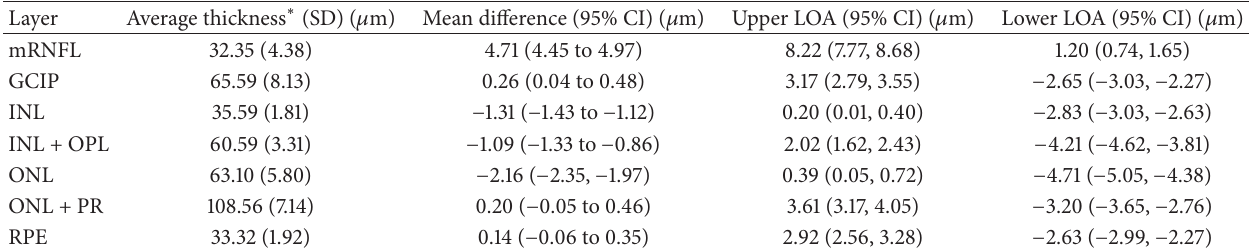
Average of thickness values derived from both OCT platforms. mRNFL: macular retinal nerve fiber layer; GCIP: ganglion cell layer + inner plexiform layer; INL: inner nuclear layer; INL + OPL: inner nuclear layer + outer plexiform layer; ONL: outer nuclear layer; ONL + PR: outer nuclear layer + photoreceptor segments; RPE: retinal pigment